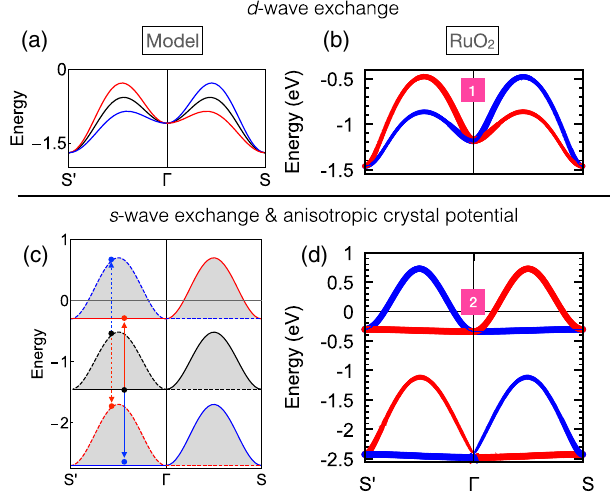
FIG. 10. (a) Schematic diagram of the anisotropic ( d -wave) exchange Fermi-liquid instability in the altermagnet. The black line corresponds to the spin-degenerate band in the nonmagnetic phase, while red and blue lines are spin-split bands in the altermagnetic phase. (b) Spin-projected (and orbital-projected) ab initio bands of RuO 2 in the energy window corresponding to panel (a). (c) Schematic diagram of the isotropic ( s -wave) exchange Fermi-liquid instability combined with anisotropic crystal potential in the altermagnet. Solid and dashed black lines correspond to the spin-degenerate bands dominated by one or the other sublattice in the nonmagnetic phase, respectively. Red and blue lines are spin-split bands in the altermagnetic phase. (d) Spin-projected (and orbital-projected) ab initio bands of RuO 2 in the energy window corresponding to panel (c). Pink boxes with labels 1 and 2 correspond to the full ab initio bands of RuO 2 shown in Fig. 3(c). This figure is adapted from Ref.